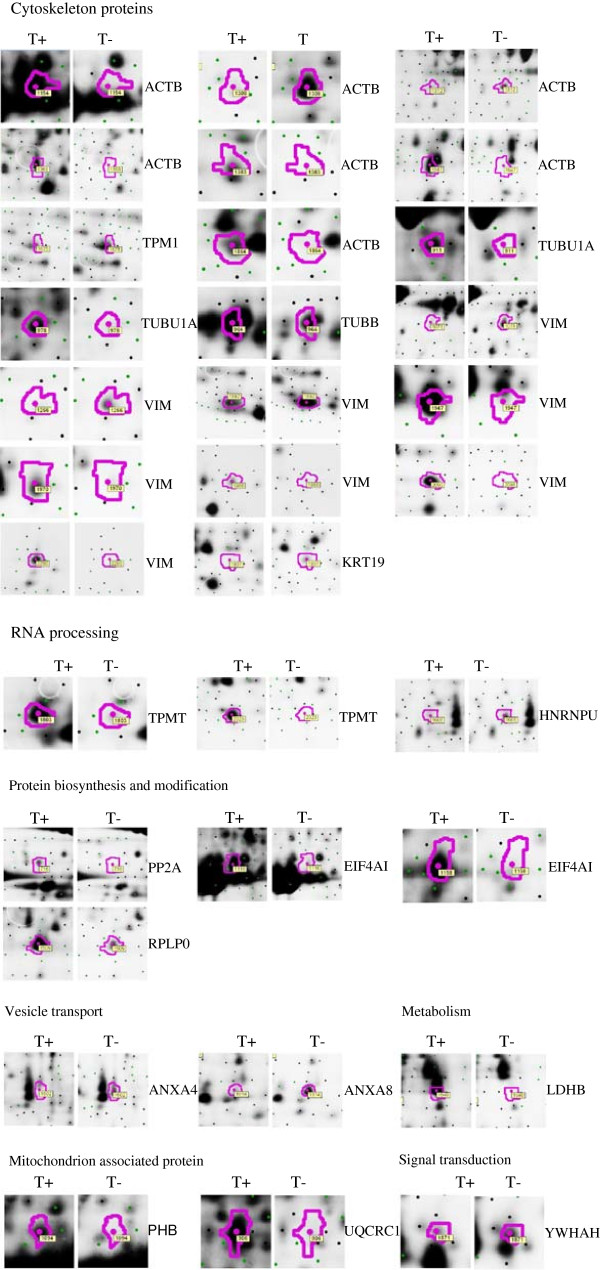
Image of ImageQuant and DeCyder analysis of 35 differentially expressed protein spots in 2D DIGE gels. T + and T- represent TGEV-infected and mock-infected ST cells, respectively.